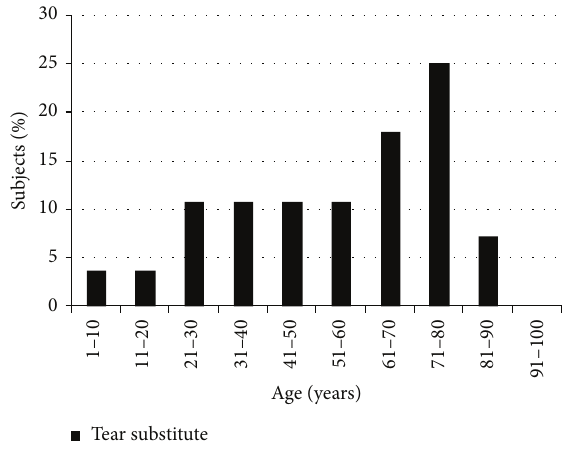
Figure 8: Percentage of tear substitutes by age